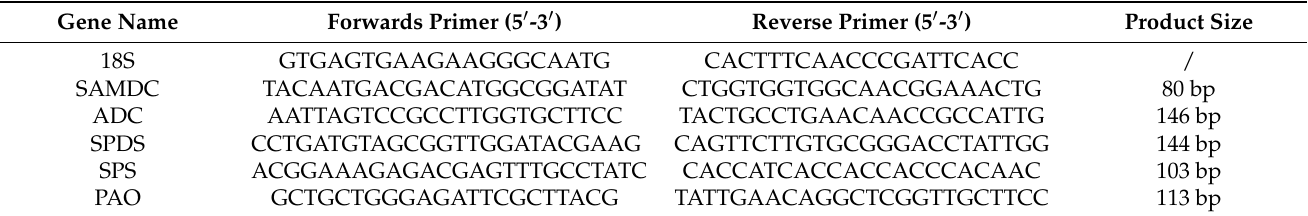
Table 4. Sequence information of primers of genes of interest used in qRT-PCR